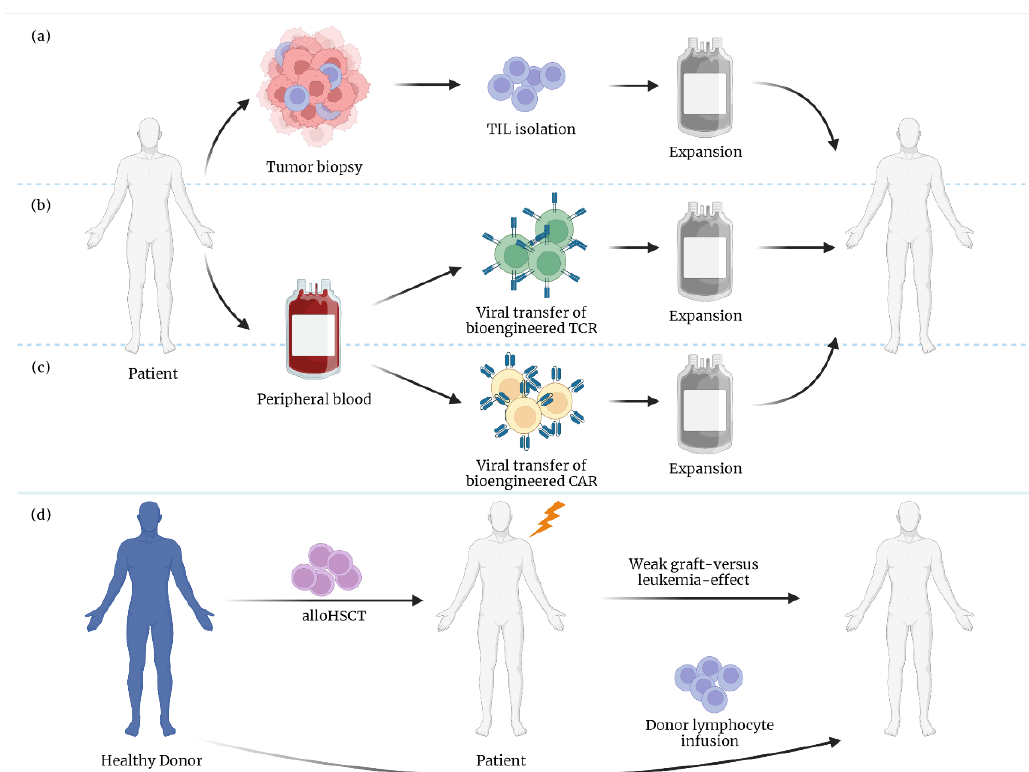
Figure 1. Adoptive T cell transfer. ( a ) Tumor-infiltrating lymphocytes are isolated from tumor tissue and ex vivo expanded. Afterwards, expanded cells are delivered back to the patient. ( b , c ) Peripheral blood is collected from cancer patients. T cells are then isolated and transduced with either ( b ) a T cell receptor (TCR) specific against tumor neoantigens or ( c ) a chimeric antigen receptor (CAR) targeted against cancer-related antigens. Both types of T cells are then expanded in vitro before infusion into the patient. ( d ) In allogeneic hematopoietic stem cell transplantation (alloHSCT), the patient’s immune system is eliminated by conditioning and replaced by foreign immune cells arising from healthy donor hematopoietic stem cells. However, leukemic cells can persist or reoccur due to a weak graft-versus-leukemia effect. Infusion of allogeneic peripheral T cells from the stem cell donor after transplantation, termed donor lymphocyte infusion (DLI), can eradicate residual leukemic cells.